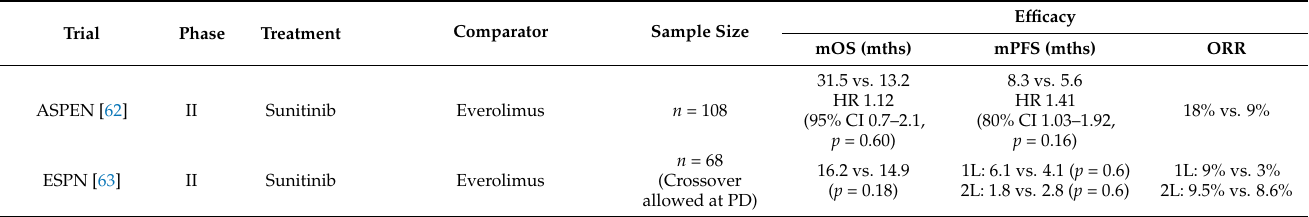
Table 4. Prospective targeted therapy trials in nccRCC